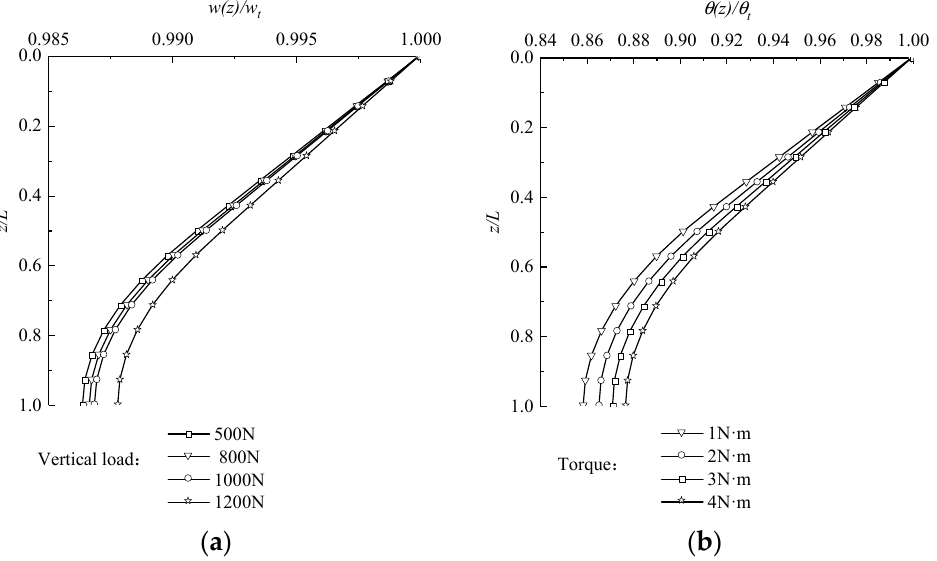
Figure 12. Normalized results under di ff erent loads. ( a ) Vertical displacement. ( b ) Torsion angle.